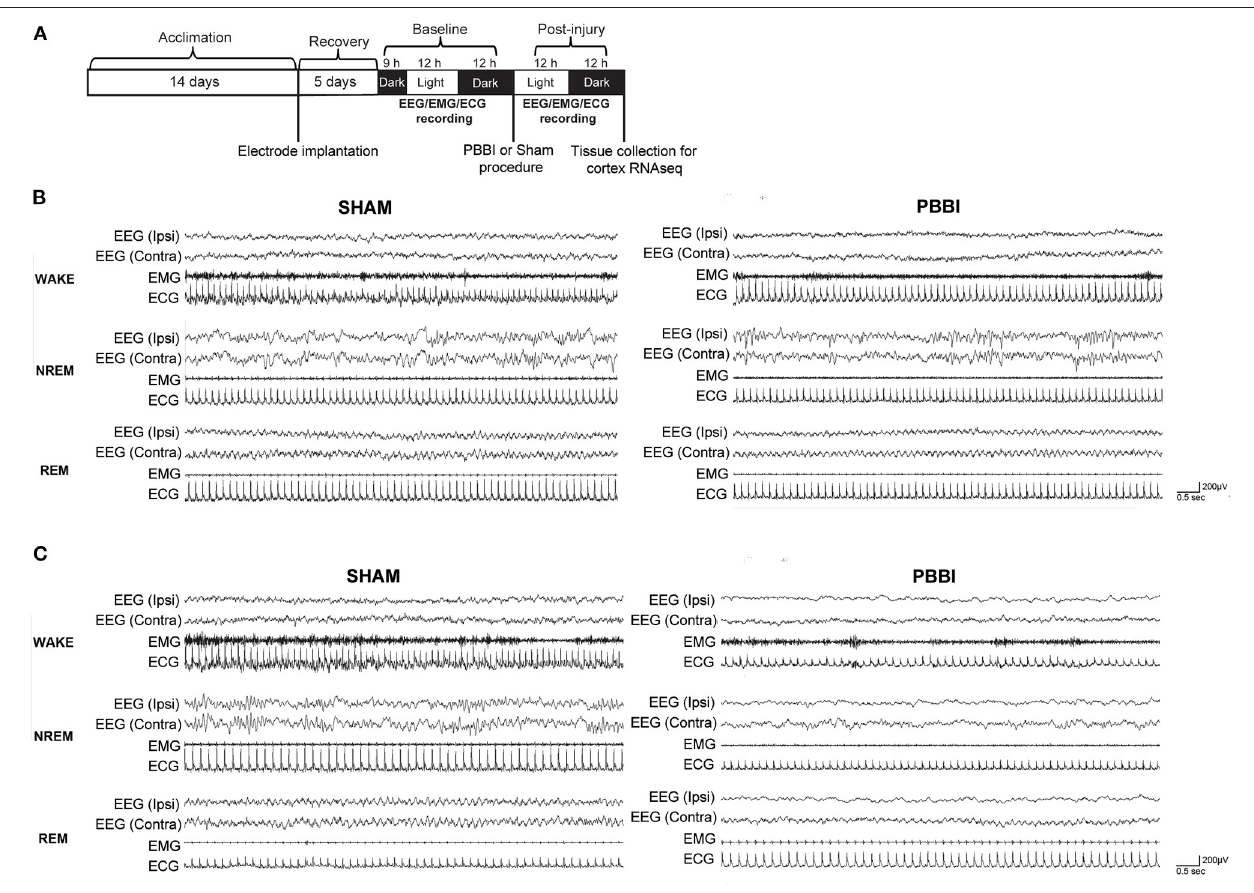
FIGURE 1 | (A) Schematic of experimental timeline for EEG/EMG/ECG recording and molecular analysis. Representative recordings (B) pre-injury and (C) acute ( < 24h) post-PBBI in sham and PBBI rats. PBBI was performed on the right (ipsilateral) side. Spectral tracings from all three vigilance states (wake, NREM, and REM) following PBBI demonstrated slightly attenuated voltages and reduced frequencies acutely over the ipsilateral cortex. No overt changes over the left (contralateral) cortex were detected. EMG and ECG tracings demonstrate muscle activity and heartbeat,